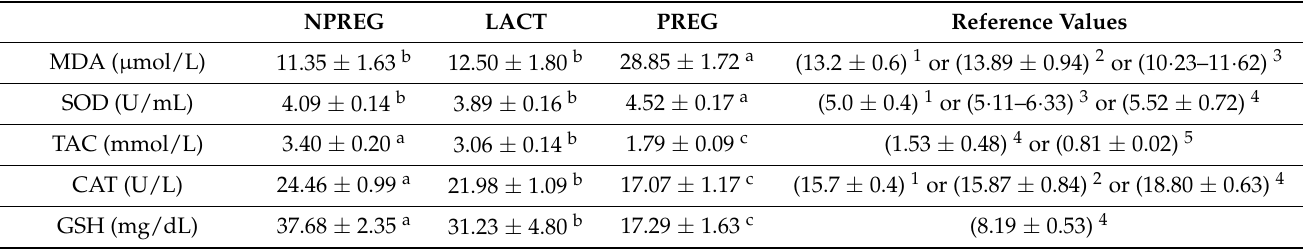
Table 3. Mean values (M ± SD) of MDA, SOD, TAC, CAT and GSH in non-pregnant non-lactating ( n = 14), non-pregnant lactating ( n = 8) and pregnant ( n = 38) she-camels. NPREG LACT PREG Reference